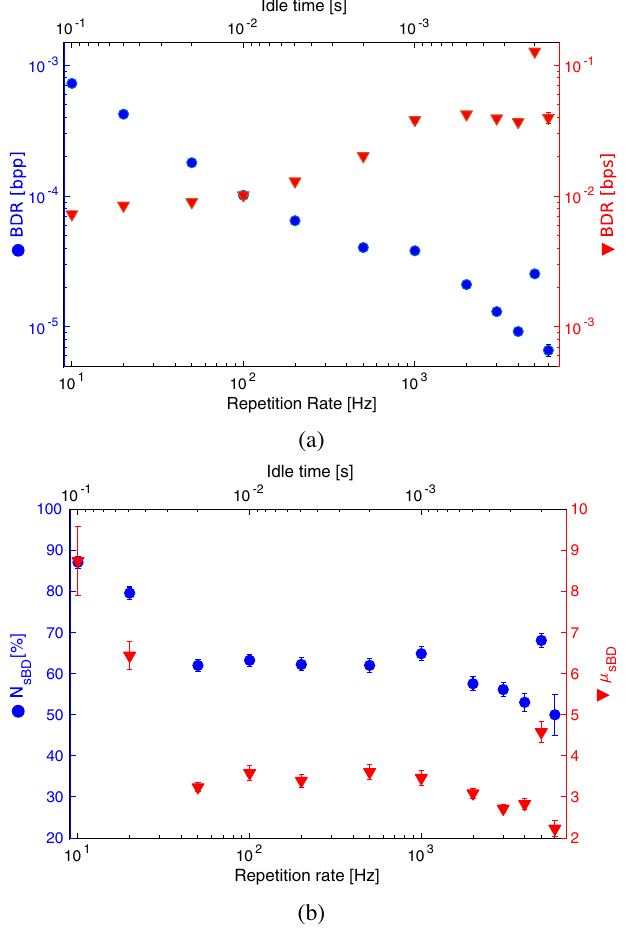
FIG. 6. BD experiments with variable repetition rates. (a) shows the BDR as BDs per pulse and as BDs per second for each repetition rate. (b) shows the fraction of secondary BDs N the mean number of secondary BDs after a primary one, μ each repetition rate. In each graph, the uncertainties are estimated ¼ 5000 V in from the standard error of the mean, though many of the error target bars are too small to be